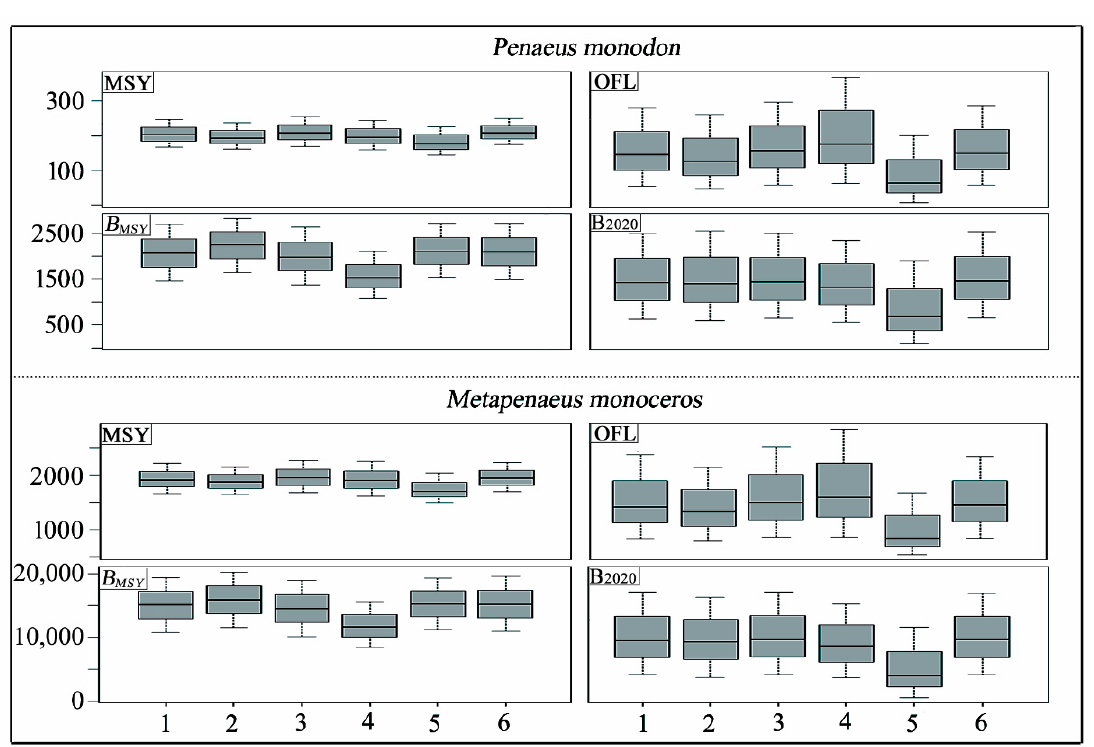
Figure 7. Sensitivity analysis for both Penaeus monodon and Metapenaeus monoceros. The scenarios are 1. The base model outputs; 2. M increases to 2; 3. F MSY /M decreases to 0.8; 4. B MSY /K decreases to 0.25; 5. B t /K decreases to 0.2; 6. B 1 /K decreases to 0.8. Different values (50–500 metric tons for P. monodon and 500–1500 metric tons for